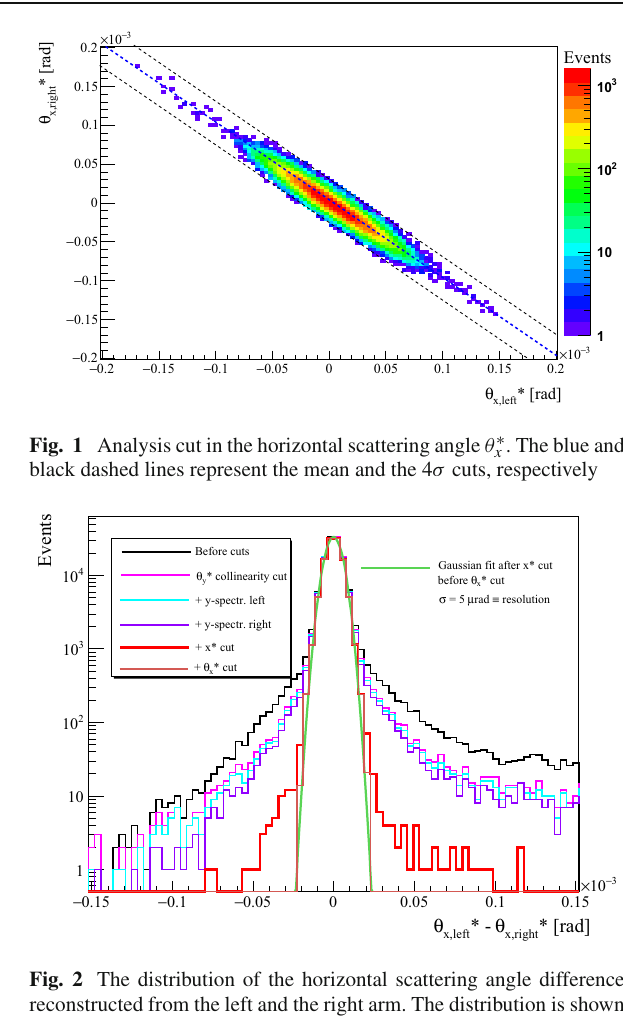
Fig. 2 The distribution of the horizontal scattering angle difference reconstructed from the left and the right arm. The distribution is shown before any analysis cut (black solid line) and after each analysis